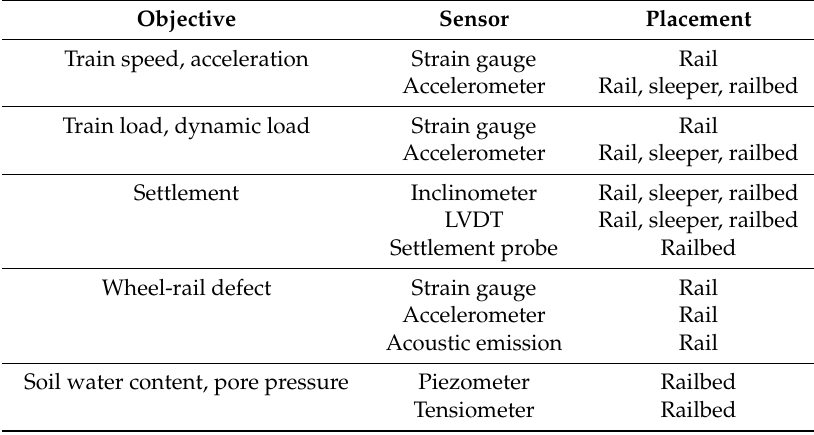
Table 2. The objectives of the sensors for railway track monitoring.